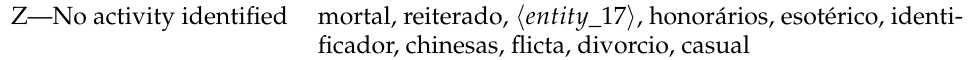
Table 16. Top-10 features for economic activity prediction using numerical data removal with SVM. Z—No activity identified